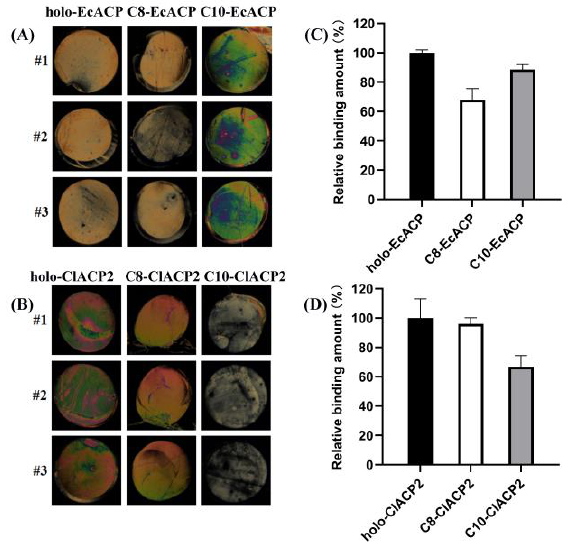
Figure 5. Binding affinity of ChFatB2 with the ACPs determined by liquid crystals assay. ( A , B ) show the optical micrographs of a thin layer of liquid crystal under polarized microscope. The liquid crystals were sandwiched between a DMOAP-coated glass slide and a DMOAP-coated glass slide with circular domain of immobilized ChFatB2 and EC-holo-ACP, C8-, and C10-EcACP ( A ), and immobilized ChFatB2 and holo-ClACP2, C8-ClACP2, and C10-ClACP2 ( B ). ( C , D ) are the grayscale values of the optical images of ( A , B ) obtained by Image J software. The analysis was repeated three times (#1, #2, and #3).